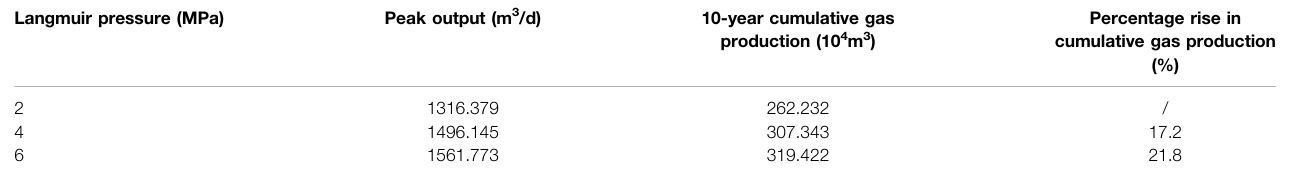
TABLE 5 | Effect of Langmuir pressure on CBM production.